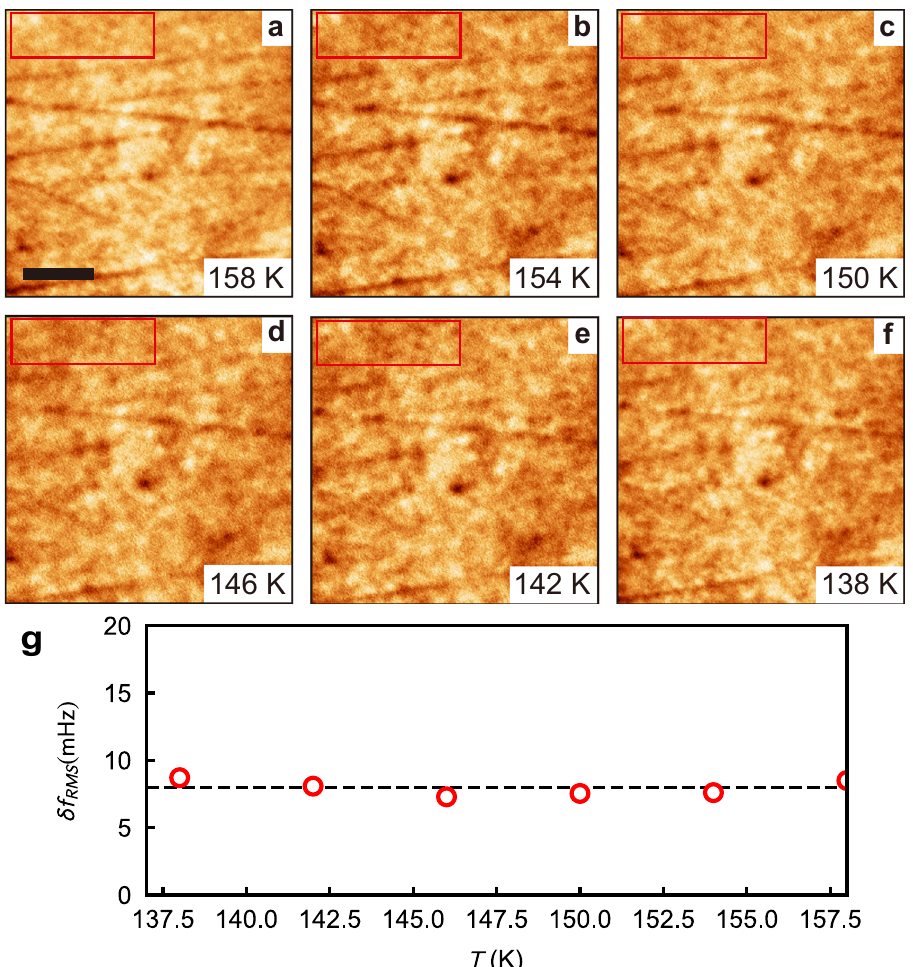
Fig. 3 Absence of signi fi cant change when the sample is cooled down through T N . a – f MFM images taken on a rough region while the fi lm is fi eld-cooled through T N = 150 K from room temperature in 9 T. Scale bar in a : 1 μ m. Image size: 4 × 4 μ m 2 . g The root-mean-square (RMS) of the magnetic contrast in the region marked by the dashed red rectangle in the images of a . The color scale is 75 mHz for all the MFM